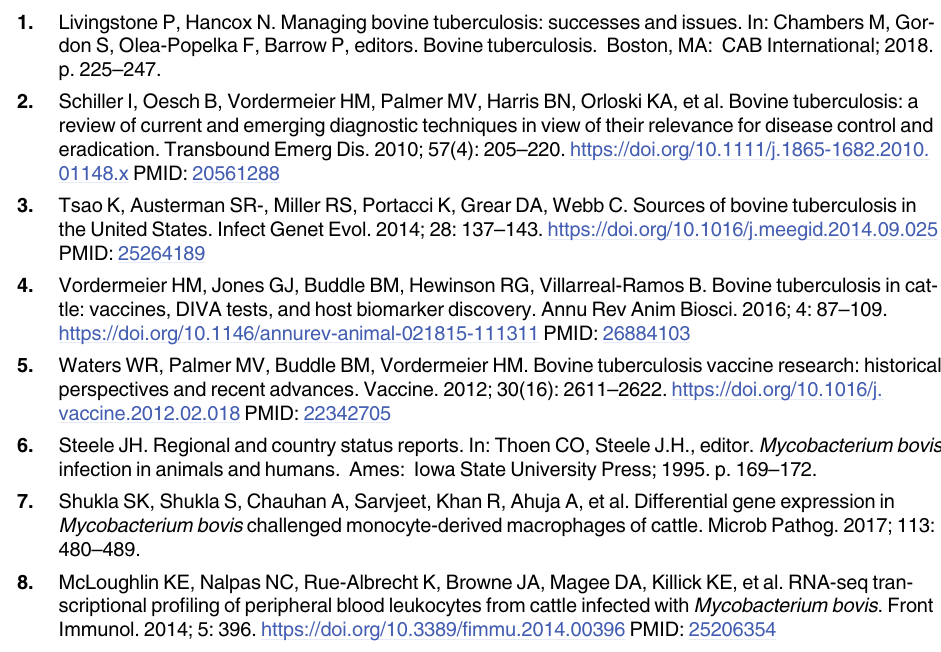
S3 Fig. Enriched biological processes in uninfected compared to M . bovis infected cattle. Top 5 enriched biological processes from each group based on lowest p values. P-values all < 0.05. Uninfected cattle n = 5, moderately affected cattle n = 3, severely affected cattle n = 4.